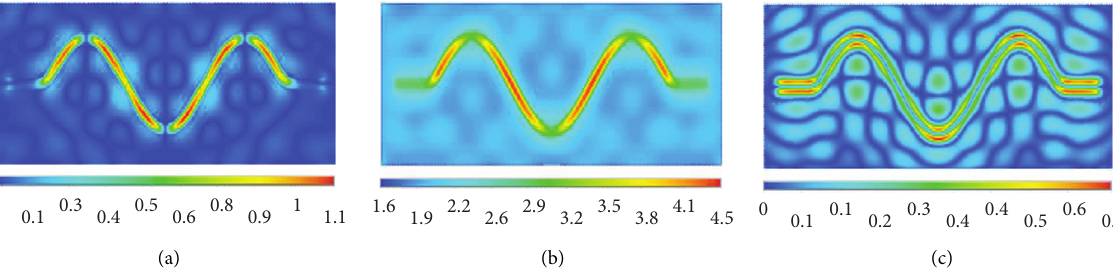
Figure 62: SH wave incident (NR � 3, f � 1.5.0Hz, H � 100m, and C